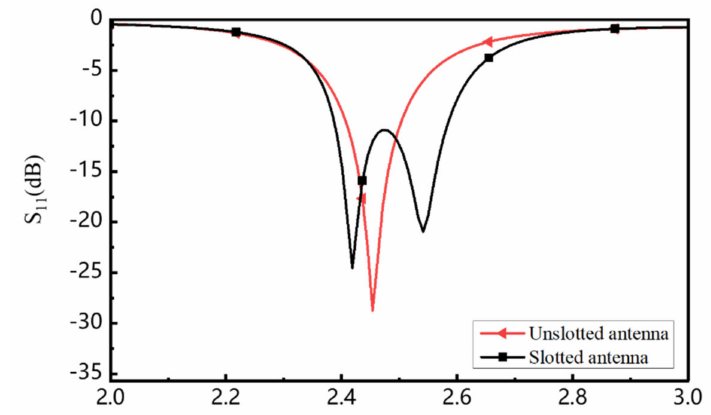
Figure 2. Comparison of the simulated return losses for the